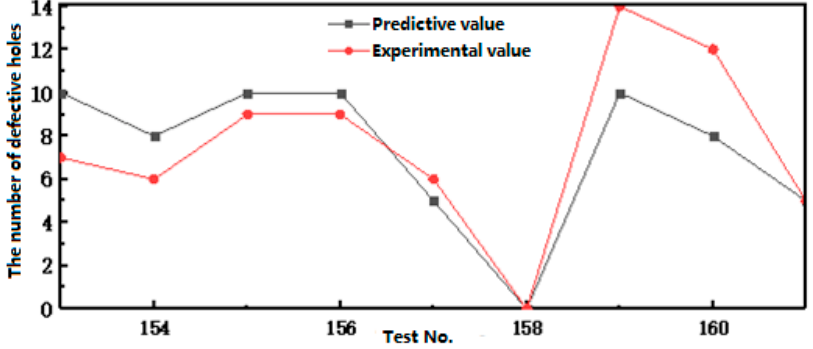
Figure 9. The comparation of predicted and expected values.